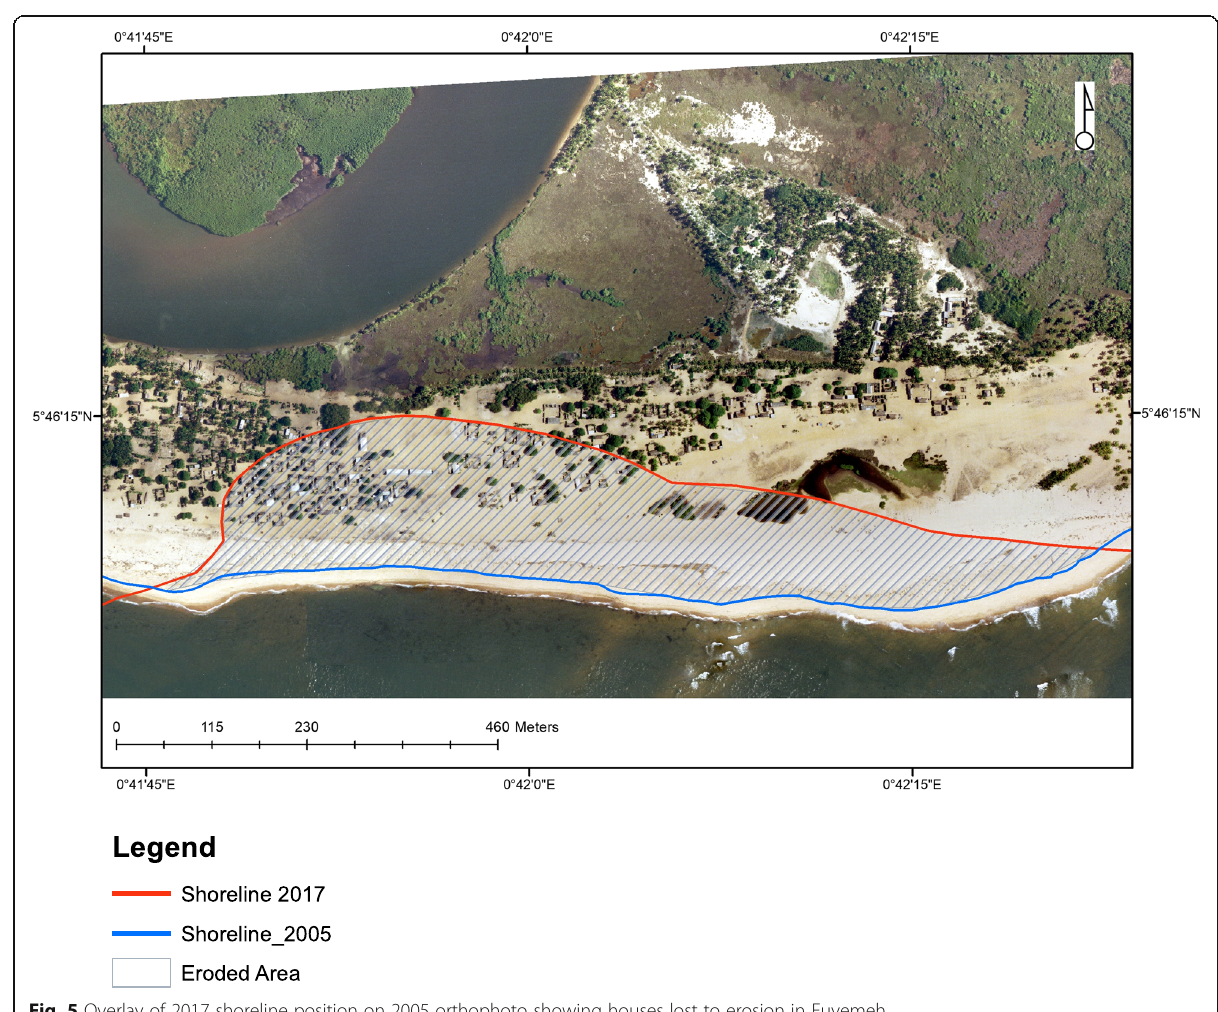
Fig. 5 Overlay of 2017 shoreline position on 2005 orthophoto showing houses lost to erosion in Fuvemeh